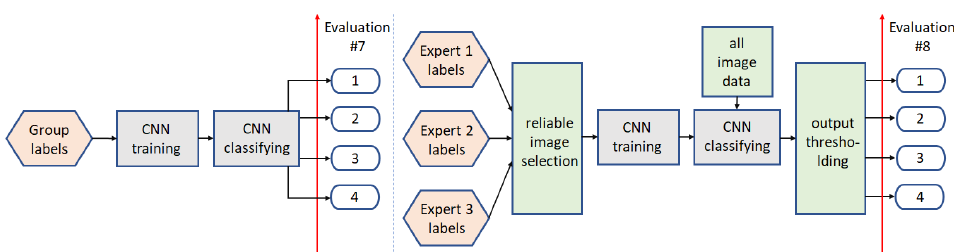
Figure 8. Multi-class analysis: Path5 ( left ) and path6 ( right